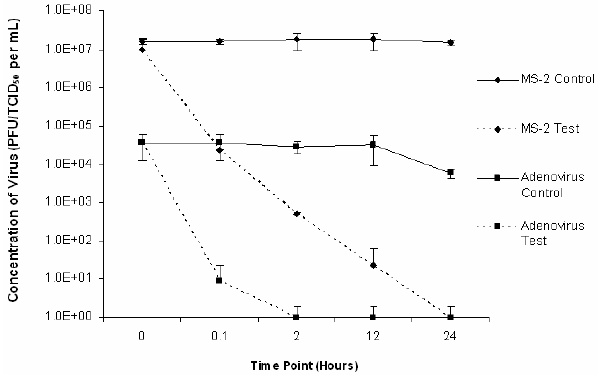
Figure 2: Average adenovirus type 5 and MS2 inactivation in sludge matrices (compost, raw and previously limed) lime stabilized at reduced temperature (4 ±